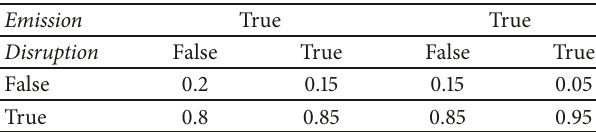
Table 12: NPT for port